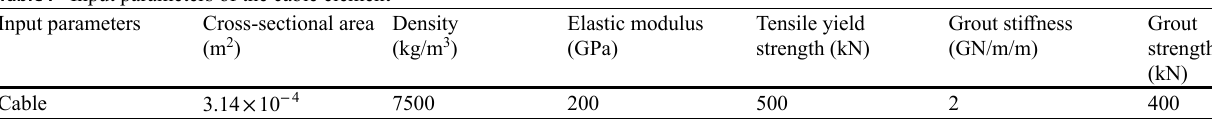
Table 7 Input parameters of the cable